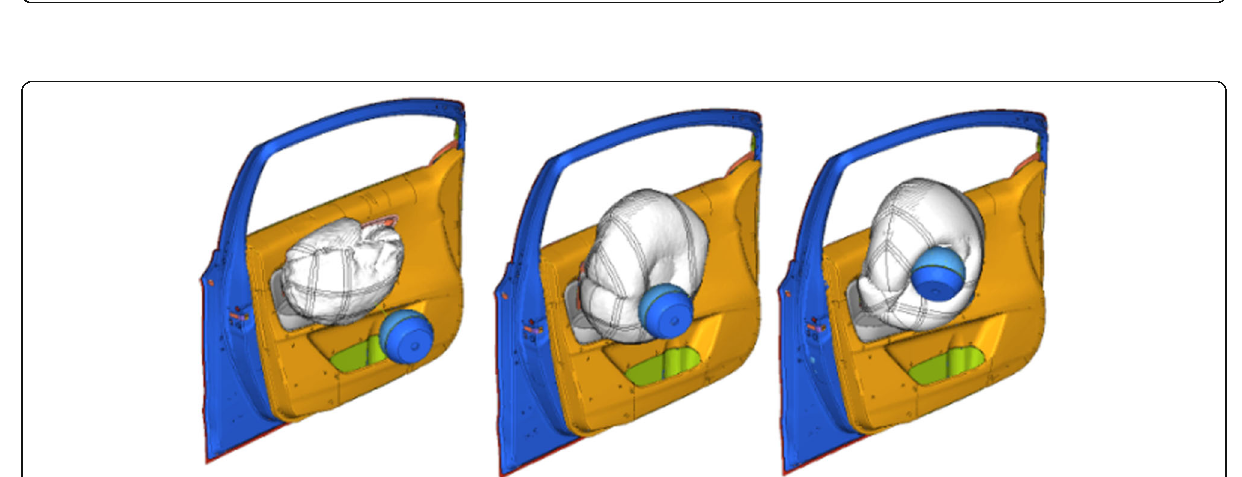
Fig. 15 The result of head injury value without the airbag protection at the opening angle of 70°